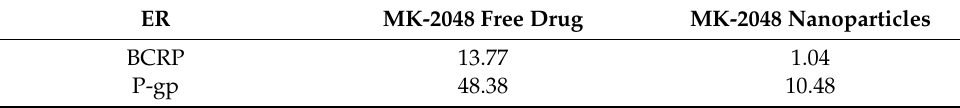
Table 2. Efflux Ratio (ER) values in two transporter-overexpressed cell lines.